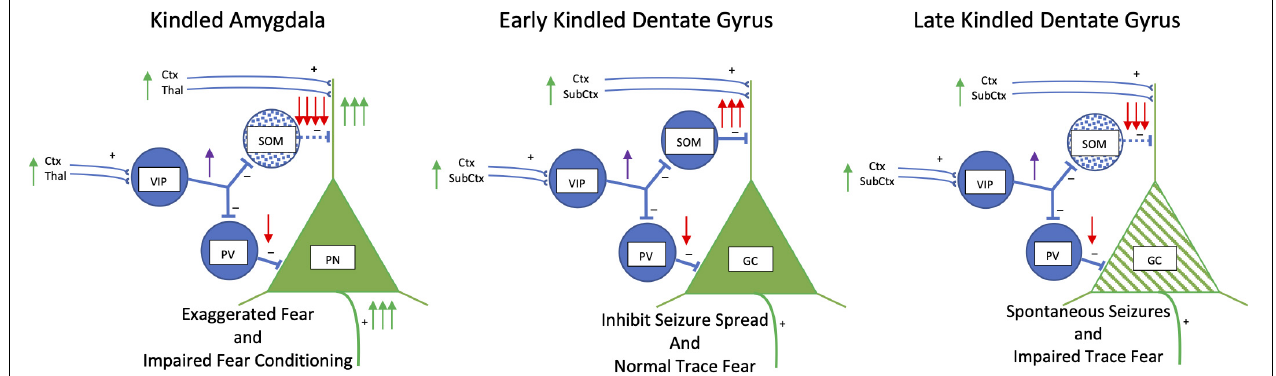
FIGURE 3 | Kindling: Somatostatin. Simplified schematic drawing of the effects of amygdala kindling on somatostatin. In the basolateral amygdala in the left panel, kindling produces a loss of somatostatin interneurons (blue stippling). This releases the glutamatergic principal neurons from strong dendritic inhibition and inhibition at the soma to increase activity of these neurons. This results in exaggerated fear but also an impairment in fear conditioning. In the middle and right panels, the effects of early and late amygdala kindling in the dentate gyrus are shown. During early phases, kindling induces an increase in the number of somatostatin interneurons is induced which strongly inhibits dendritic activity. The strong inhibition reduces the spread of kindled seizures, but trace and context fear conditioning persist. However, during late amygdala-kindling ( ∼ 100 stimulations), somatostatin interneurons die, and spontaneous seizures develop. There is a mix of dendritic retraction, loss of spines, and an increase in axonal grow in granule cells (green hatching). Function of the hippocampus is altered leading to impairment of trace and context fear conditioning. Abbreviations are the same as in Figure 2